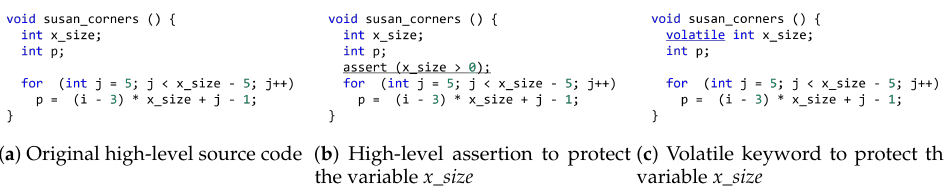
Figure 2. Our high-level protection schemes to protect critical